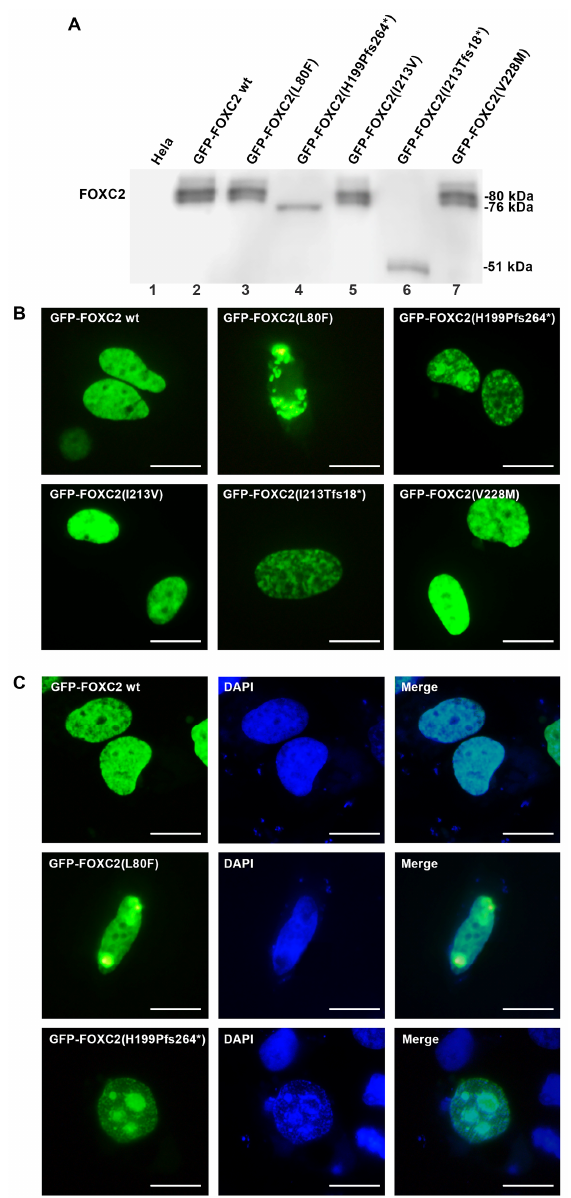
Figure 2. FOXC2 protein expression of mutant recombinant plasmids. ( A ) Western blot analysis of exogenous FOXC2 protein expression in HeLa cells transfected with wild type and mutant plasmids (pFOXC2-GFP; pFOXC2 (L80F)-GFP; pFOXC2(H199Pfs*264)-GFP; pFOXC 2 (I213V)-GFP; pFOXC2(I213Tfs*18)-GFP; pFOXC2(V228M)-GFP); lane 1 referred to nontransfected HeLa cells; ( B ) Immunofluorescence detection of FOXC2 mutant proteins in HeLa cells after transient transfection. HeLa cells were transfected with one of the following plasmids: pFOXC 2 -GFP, pFOXC2(L80F)-GFP; pFOXC2(H199Pfs*264)-GFP; pFOXC2(I213V)-GFP; pFOXC2(I213Tfs*18)-GFP; pFOXC2(V228M)-GFP) and fixed with 3% paraformaldehyde 24 h later. The nuclear localization of all FOXC2 mutant proteins was detected by direct immunofluorescence analysis of plasmids tagged with GFP (in green); 40 × magnification. Scale bar: 10 µ m. The frameshift and pL80F mutations gave rise to nuclear FOXC2 protein aggregates; ( C ) Immunofluorescence evaluation of HeLa cells transiently transfected with pFOXC2 -GFP, pFOXC2(L80F)-GFP; pFOXC2(H199Pfs*264)-GFP. Mutations p.L80F and p.H199Pfs*264 determined abnormal protein assembly. In green, FOXC2 proteins tagged with GFP and in blue cell nuclei stained with DAPI; 40 × magnification. Scale bar: 10 µ